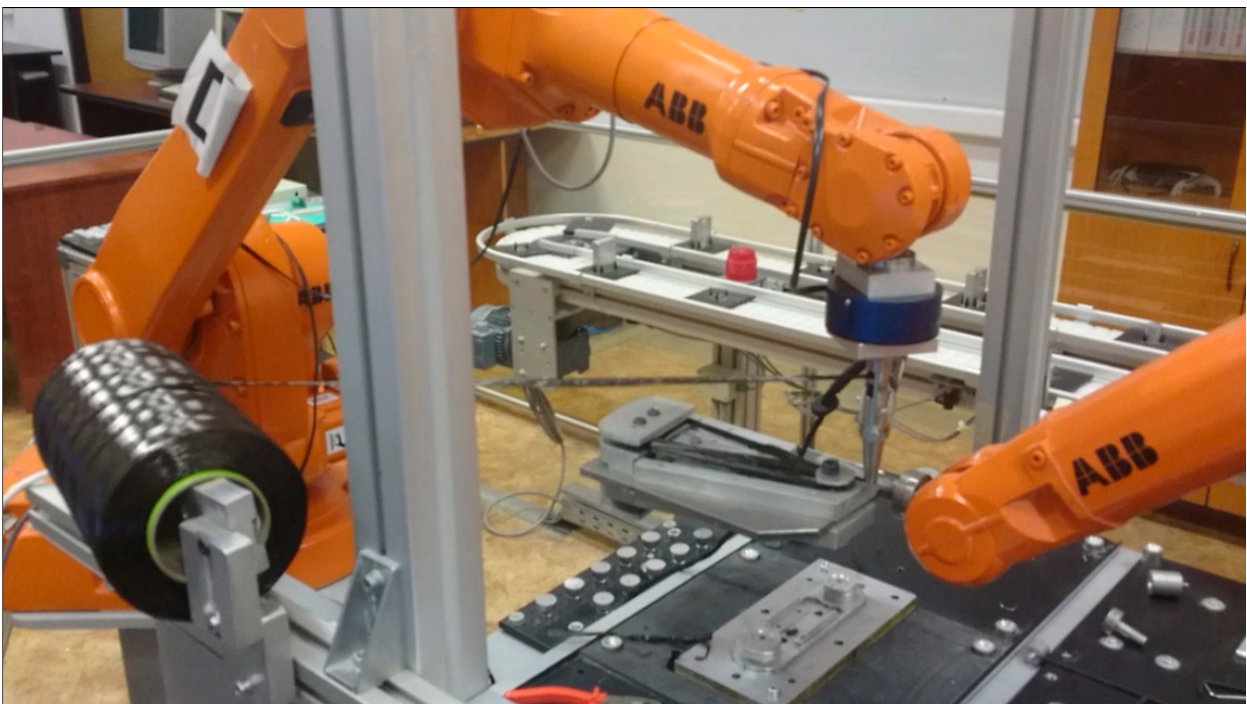
Figure 21. Robot studio robot collaboration simulation.